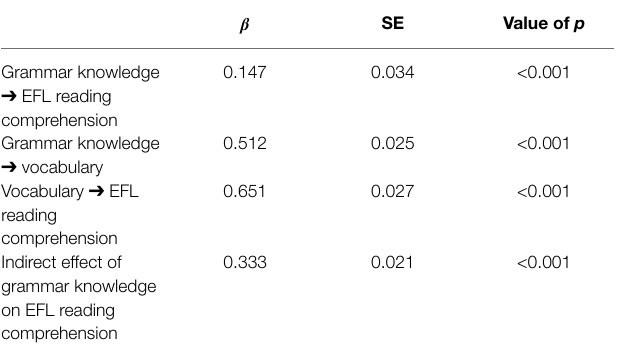
TABLE 5 | Mediation effect of